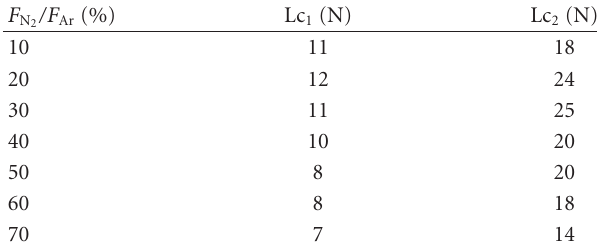
Table 5: E ff ect of N 2 flow on critical loads during scratch tests for NbN coatings on SS.